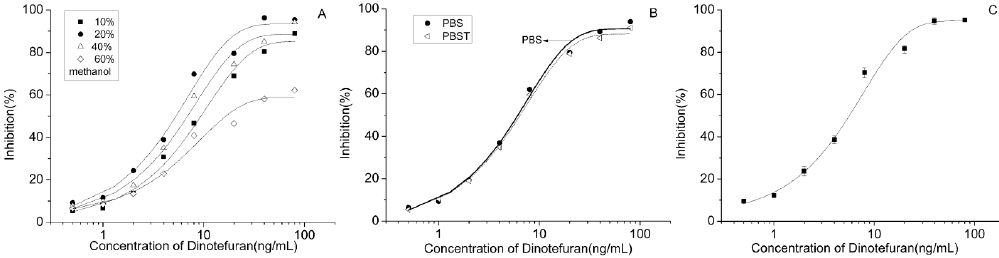
Figure 3. Inhibition curves of the antibody ( A , optimization to the methanol proportion; B , selection between PBS and PBST; and, C , the optimized curve).